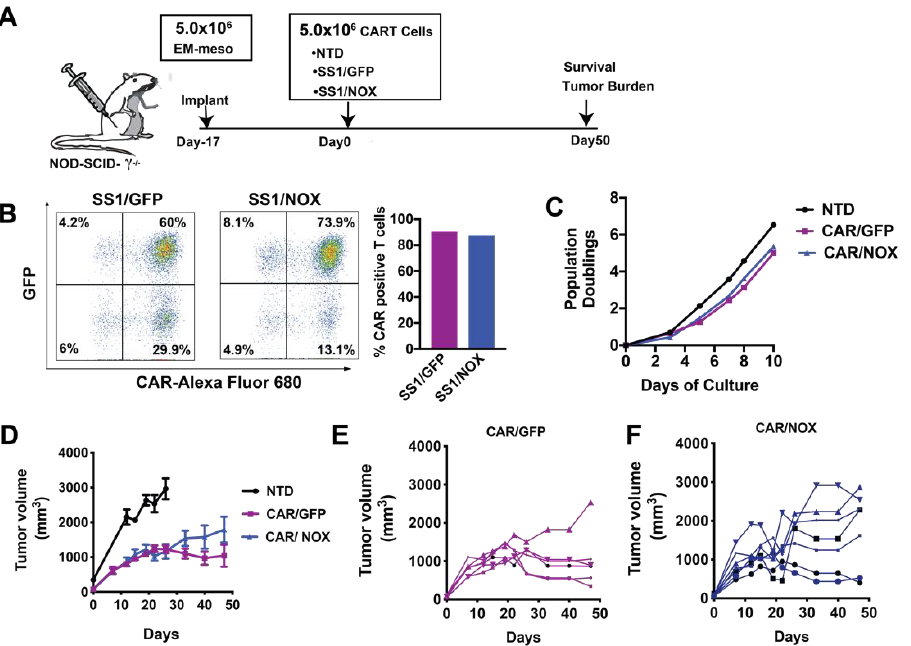
Figure 5. Investigating the antitumor function of Lactobacillus brevis NADH Oxidase ( Lb NOX)-expressing CAR T-cells. ( A ) Experimental layout including a schematic of the EM-meso xenograft model. ( B ) A total of 5 × 10 6 EM-meso cells were injected subcutaneously into adult NSG mice. ( C ) Activated T-cells were co-infected with a mesothelin-specific (28 ζ ) CAR and Lb NOX lentiviral supernatants, then expanded over 9 days. ( D ) Surface SS1 CAR expression was measured by staining with a biotinylated goat anti-mouse IgG (H+L) followed by streptavidin (SA) Alexa Fluor 680 labeling. Lb NOX levels were simultaneously detected by GFP expression. CAR+ cells were defined as double positive for LbNOX ( Y -axis) and Alexa Fluor 680 ( X -axis). ( E ) Expansion curves showing the number of population doublings per cell over 10 days. Cell enumeration was performed every other day beginning on day 3 until the number of cells in the culture ceased increasing and the mean cell volume was below 350 fL. ( F ) A total of 5 × 10 6 CAR+ T-cells were I.V. injected 17 days after tumor implantation (NTD: n = 4; CAR/GFP: n = 6; CAR/NOX: n = 7). Tumor volumes were measured by caliper at the indicated time-points as described in the Materials and Methods section. Values represent mean ± S.E.M. for each group. Tumor size (NTD vs. CAR/GFP vs. CAR/NOX) was compared by two-way ANOVA using a Holm – Sidak multiple comparison post hoc test. Tumor size was significantly less ( p < 0.05) in all CAR expressing groups relative to the NTD control (analyzed at day 26, a threshold time-point when NTD were sacrificed). No statistical differences were observed across CAR treatment groups at the nadir of tumor development (day 40) or during the terminal phase of the study.